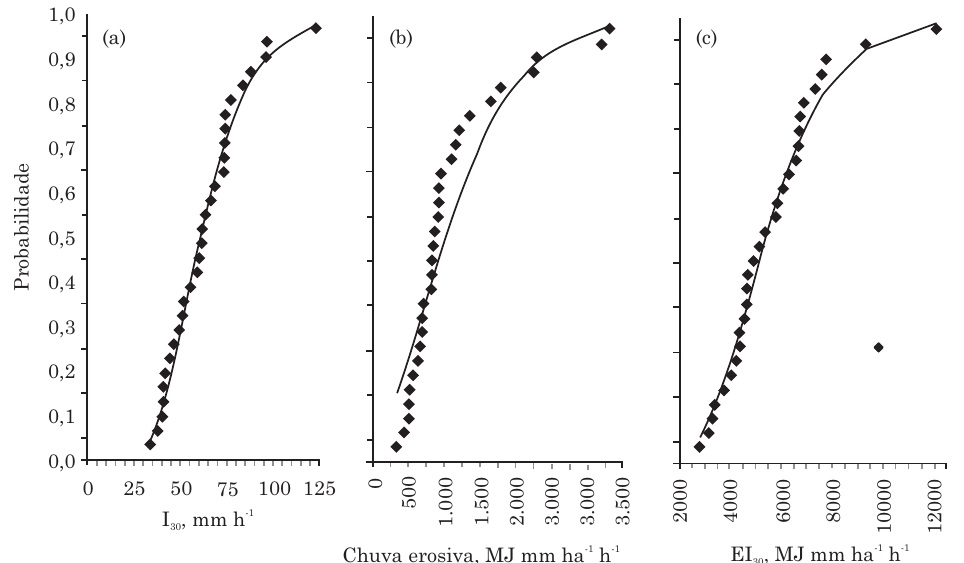
Figura 2. Estimativa da intensidade máxima em 30 min (I 30 ) (a), da chuva erosiva (b) e índice de erosividade anual de chuvas (c) para Urussanga, SC. Os diamantes azuis ( uuuuu ) representam a frequência observada e a linha vermelha (-) representa a frequência esperada, segundo a distribuição de Gumbel.